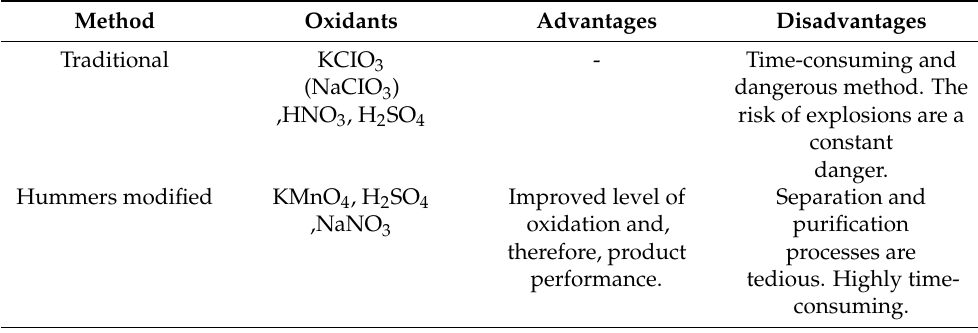
Table 2. Comparison of traditional synthesis vs. Hummers method for graphene